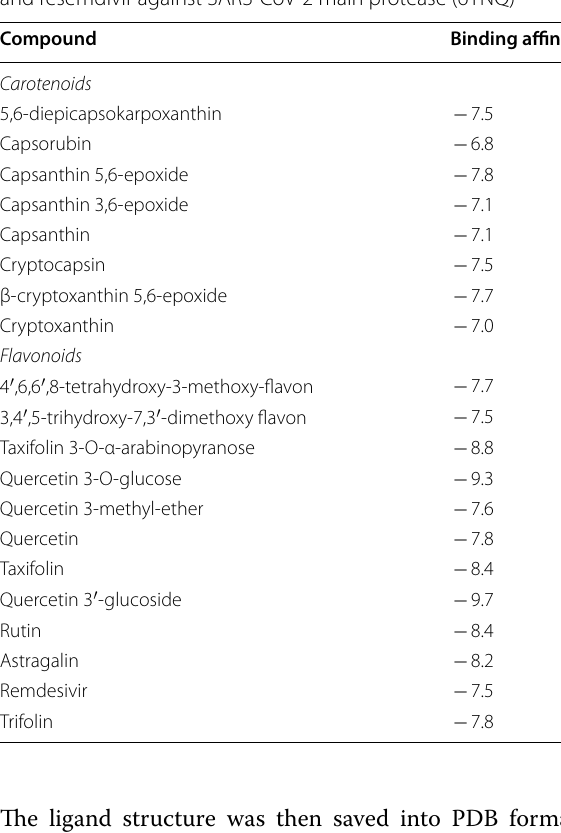
affinity of carotenoid and flavonoid